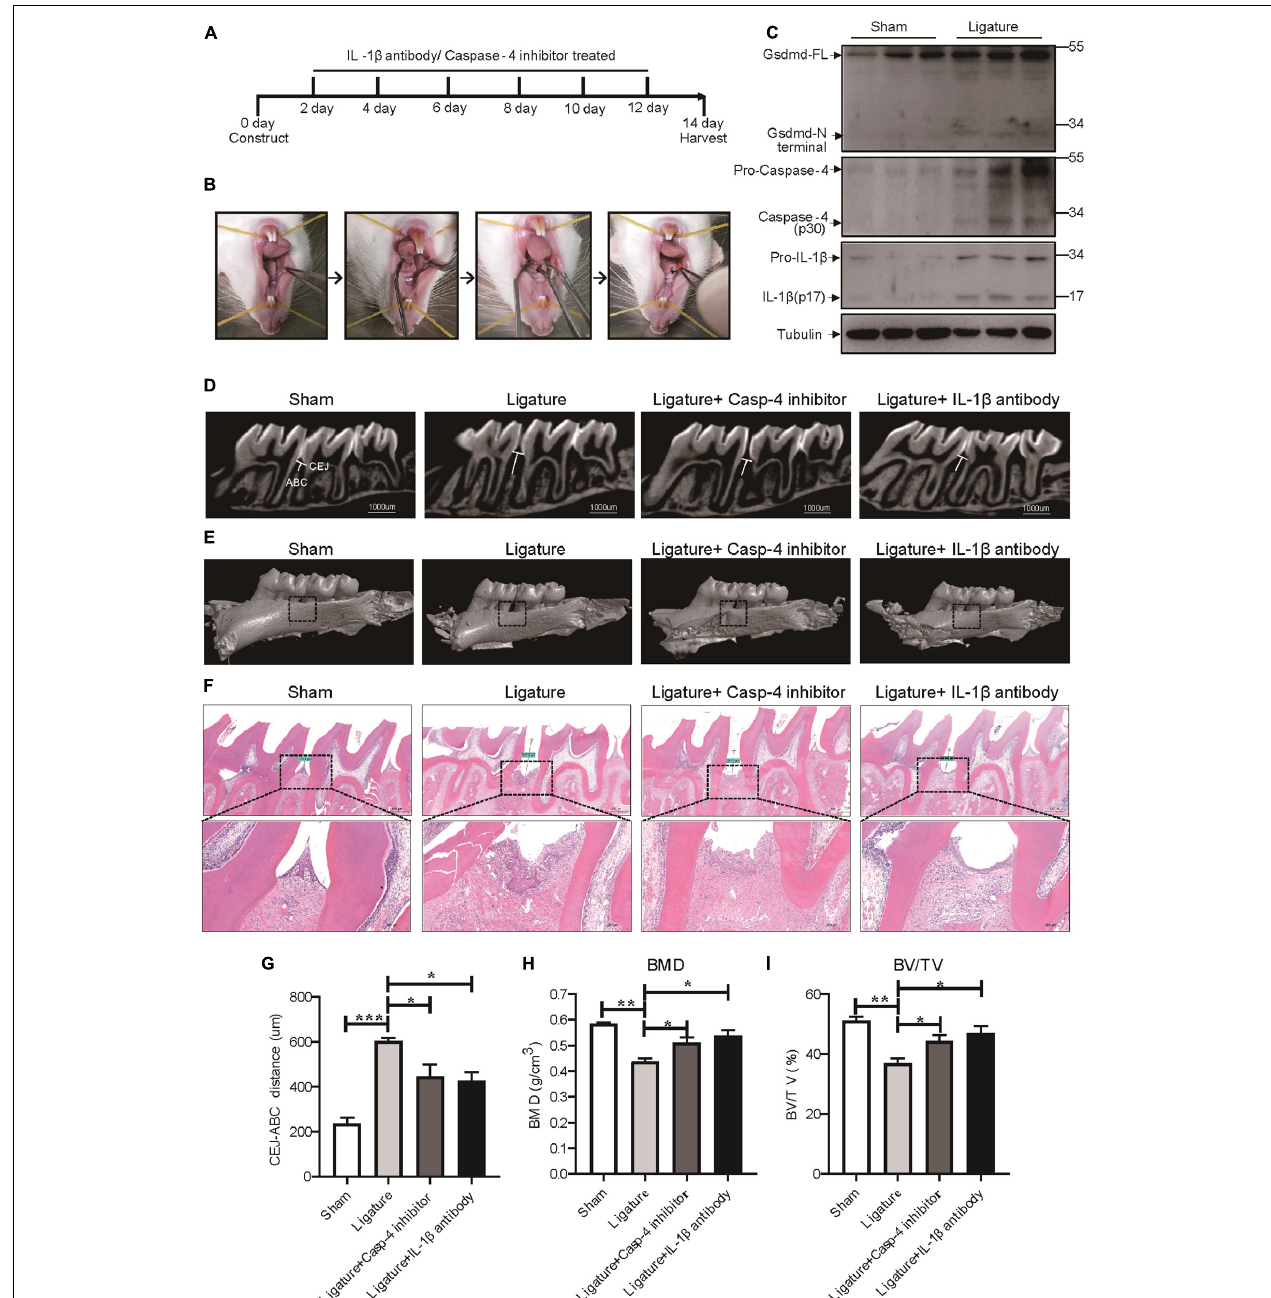
FIGURE 6 | Caspase-4-mediated non-canonical pyroptosis was involved in ligature-induced rat periodontitis. (A–I) Rats were divided randomly into a sham group, ligature-induced rat periodontitis group (ligature group), ligature with caspase-4 inhibitor injection into the subperiosteum at the left buccal and palatal gingivae of the first maxillary molars group (Ligature + Casp-4 inhibitor group), and ligature with IL-1b antibody injection into the subperiosteum at the first maxillary molar group (Ligature + IL-1b antibody group). (A) Timeline of the animal experiment. (B) Technical procedures of ligature-induced rat periodontitis. A 4-0 silk ligature was looped around the first molar of the rat maxilla under anesthesia and maintained for 14 days. The red arrow indicated the drugs injection site. (C) Periodontium tissues were collected from ligature-induced rat periodontitis group and sham group, and the expression of Gsdmd, IL-1 β , and caspase-4 was analyzed by western blot. Tubulin was used as the loading control. (D) Representative micro-CT sagittal images of maxillary molars after insertion of ligature. CEJ, cement-enamel junction; ABC, alveolar bone crest. The line indicates the distance from the CEJ to the ABC on the buccal side of the ligature site. (E) The images show the reconstructed sagittal 3D images from the computerized tomography of the maxillary molars. The squares formed by the continuous dotted line show visual differences in alveolar bone from different animal groups. (F) Tissue sections from rats were prepared after 14 days of periodontitis induction and processed for hematoxylin and eosin (H&E) staining. (G) The distances (um) between CEJ and ABC were measured after periodontitis induction. The bone mineral density (H) and bone/tissue volume (I) of the selected squares regions on the ligature site were calculated. The data are presented as the mean ± SEM. * P < 0.05, ** P < 0.01, *** P < 0.001.